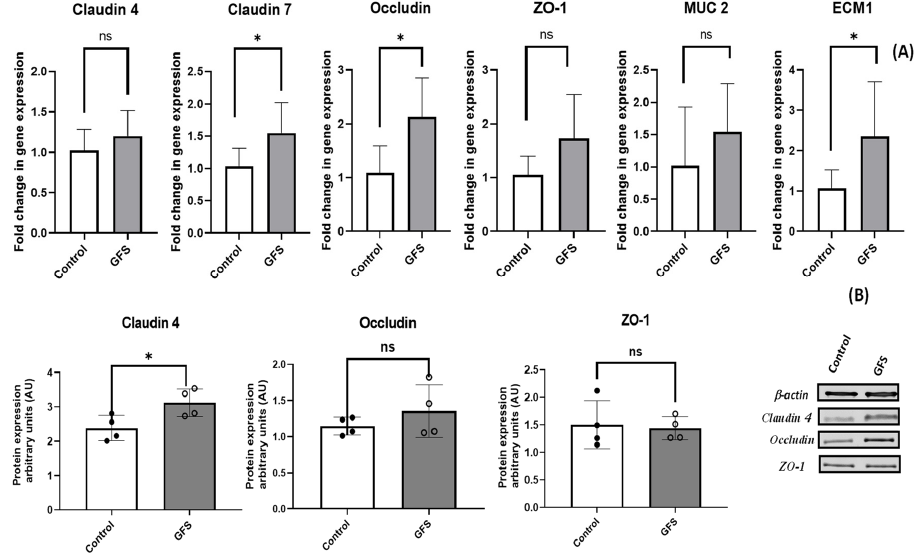
Figure 3. Effect of GFS diet on junction proteins in the colon of weaned piglets. ( A ) Fold change in gene expression of junction proteins (claudin 4, claudin 7, occludin, ZO-1) mucins (MUC 2) and proteins of extracellular matrix (ECM1) in the colon of control (white columns) and GFS-treated (grey columns) piglets. ( B ) Junction protein expression (claudin 4, occludin, ZO-1) in the colon of control (white columns) and GFS-treated (grey columns) piglets; Western blot images of junction proteins and beta-actin in the colon of control and GFS-treated piglets. The results are displayed as mean ± standard error (SE). * indicates a significant difference between control and GFS-treated piglets ( p < 0.05). ns indicates nonsignificant difference.